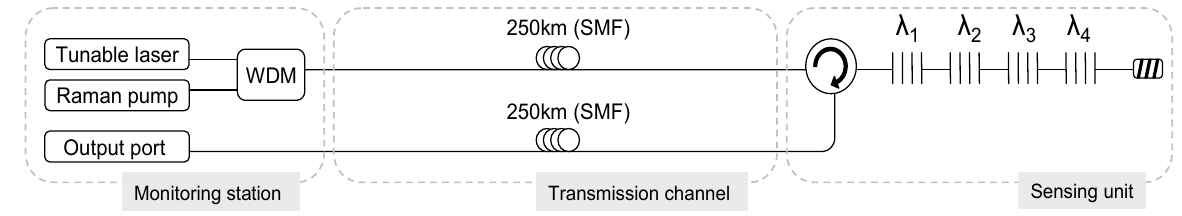
Figure 1. Schematic depiction of the ultra-long fiber Bragg grating sensor